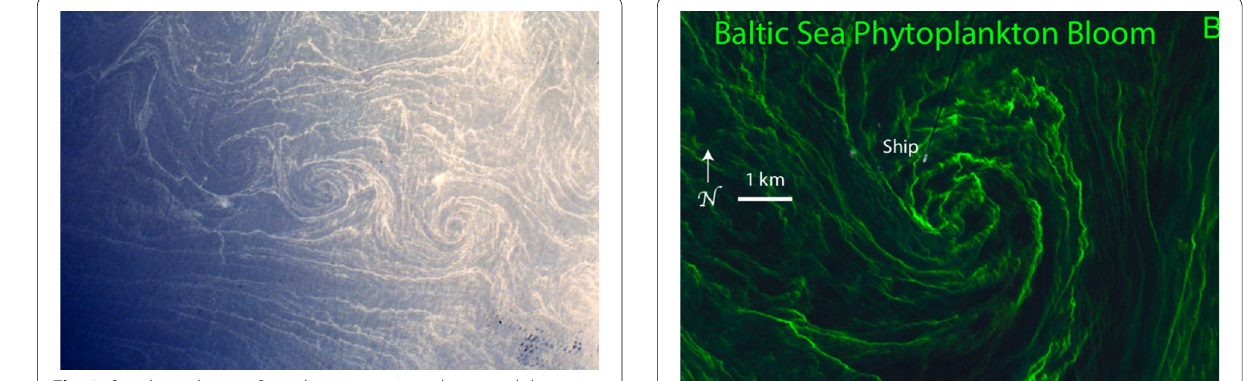
Fig. 3 Spirals on the sea. Sun-glint pattern in a photograph by an astronaut Scully-Power (1986) over the Mediterranean not far off the coast of North Africa. The lines are created by surfactants concentrated in convergence lines that alter the scattered reflection by short-surface gravity waves. Their patterns are organized by submesoscale currents. The vortex diameters are ≈ 5 km, and the surfactant lines are ≈ 100 m wide. The pattern suggests that a vortex-street roll-up has occurred from a lateral shear instability of some antecedent front, filament, or headland wake